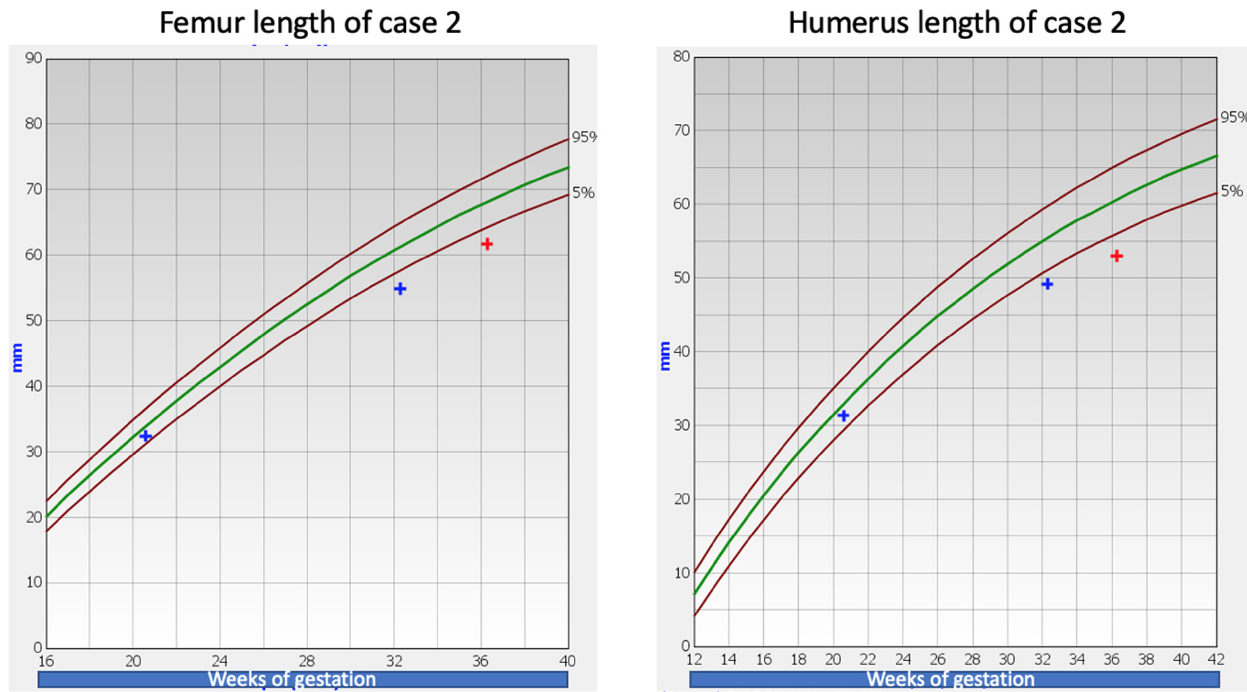
Figure 2. Femur and humerus length of Case 2 [3,4]. The green line represents the 50 th centile.